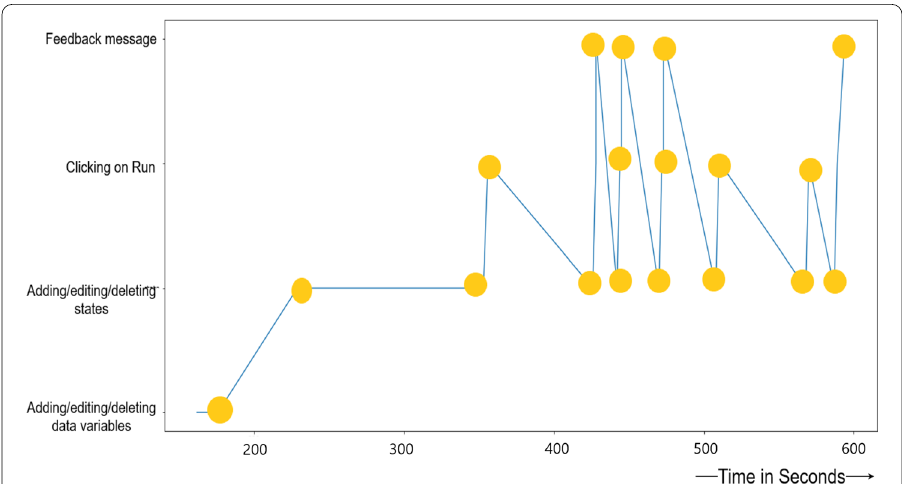
Fig. 16 Example graph of the multiple runs